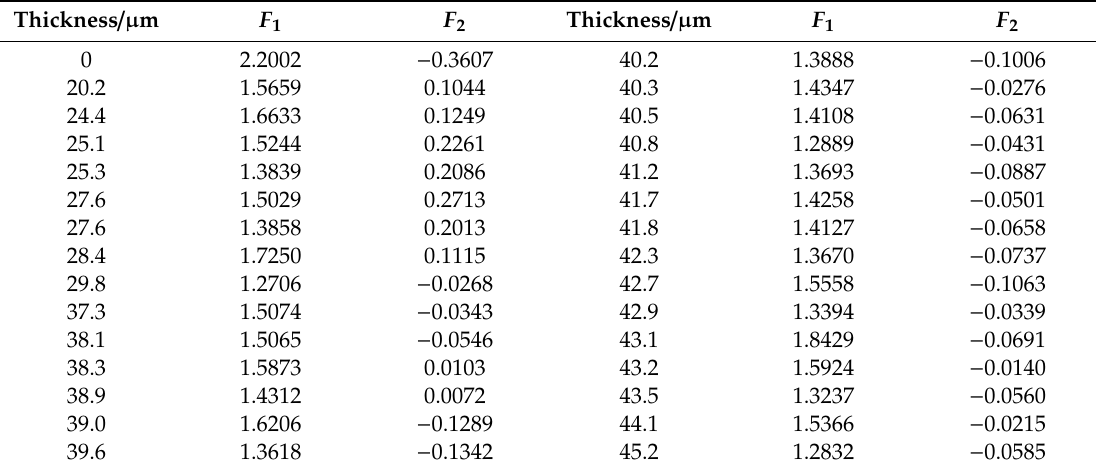
Table 6. The transformed principal component variables.